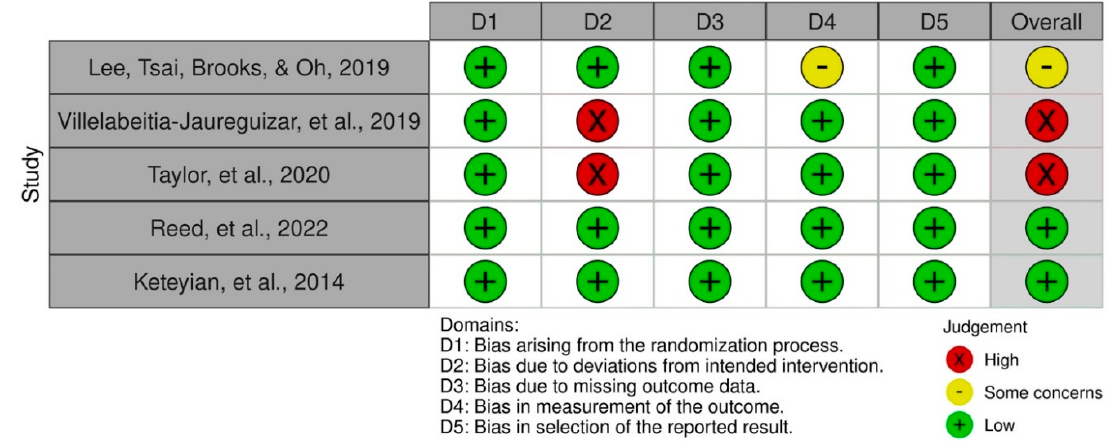
Figure 2. The evaluation regarding the risk of bias in the included studies [24–28].